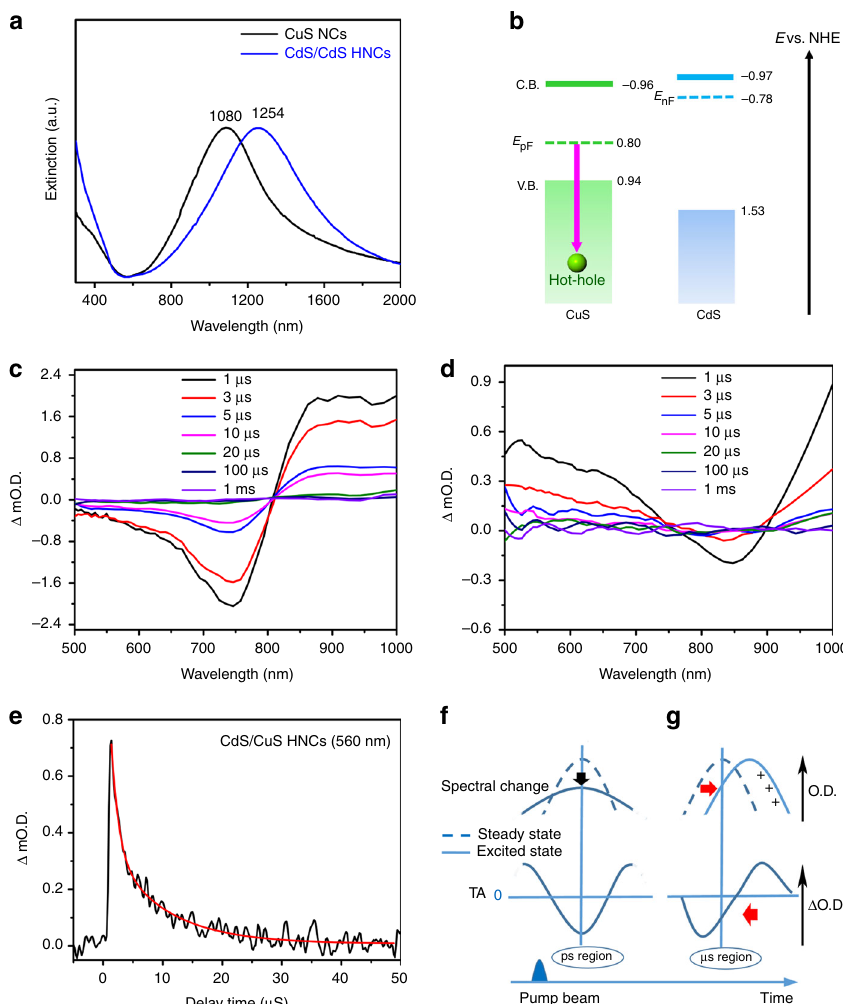
Fig. 2 Extinction spectra, band diagrams, TR-IR spectra, and a schematic illustration of time-dependent changes in TA. a Extinction spectra of CuS nanocrystals (NCs) and CdS/CuS heterostructured NCs (HNCs) in hexane. b Band diagrams of CuS and CdS phases, E pF , E nF : Fermi level, the red arrow means plasmon excitation by near-infrared (NIR) light. c , d Time resolved IR spectroscopy (TR-IR) spectral changes for c CuS NCs and d CdS/CuS HNCs from visible to near-infrared regions in the microseconds ( μ s) region. e Kinetic pro fi le of transient absorption (TA) for CdS/CuS HNCs at a speci fi c probing wavelength (560 nm) tracking holes generated in the CdS phase by NIR local surface plasmon resonance (LSPR) excitation. Red line is the best fi t. Pumping wavelength: 1200 nm. The Δ mO.D. means the change of optical density. f , g Schematic illustration of spectral changes at different timescales: f Bleaching of LSPR peak caused by hole and photon scattering in the CuS NCs observed in the ps region, and g surface hole trapping to reduce the number of holes in the intrinsic state, leading to a red-shift of the LSPR peak and blue shift of the bleaching position in the μ s